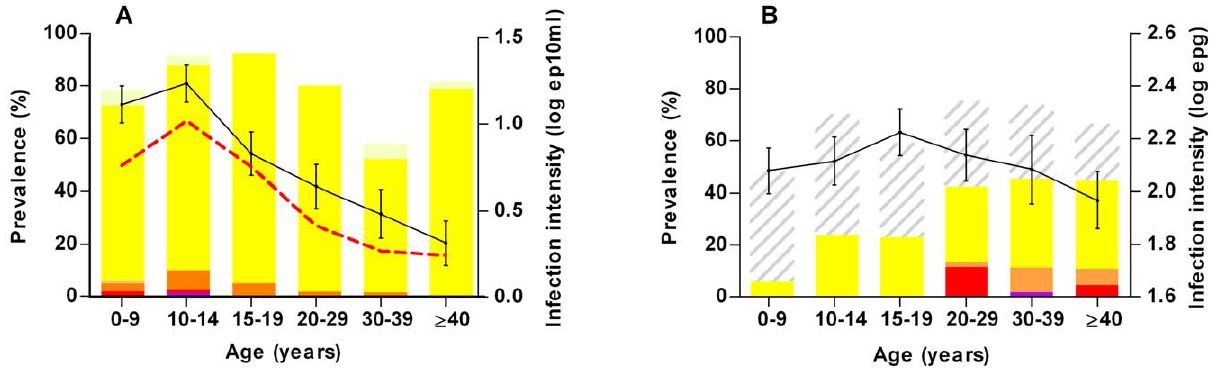
Figure 1. Age distribution of schistosomiasis morbidity in the two co-endemic communities studied. Colored stacks indicate morbidity prevalences and continuous black lines indicate mean 10log-transformed infection intensities among positive subjects with the standard error of the mean (whiskers). Panel A: Different forms of S. haematobium -specific bladder morbidity are denoted by a color gradient: light yellow stacks designate a urinary bladder score of 1, bright yellow a score of 2 and orange (3 and 4), red (5) and violet (6) indicate higher morbidity scores. The dotted red line indicates hematuria prevalence in a subsample (n=317). Panel B: The severity of S. mansoni -specific fibrosis is denoted by a color gradient. Yellow stacks designate liver image pattern C, orange pattern D, red pattern E, and violet stacks indicate pattern F. Striped stacks designate those with borderline liver morbidity (pattern B, not classified as morbidity).